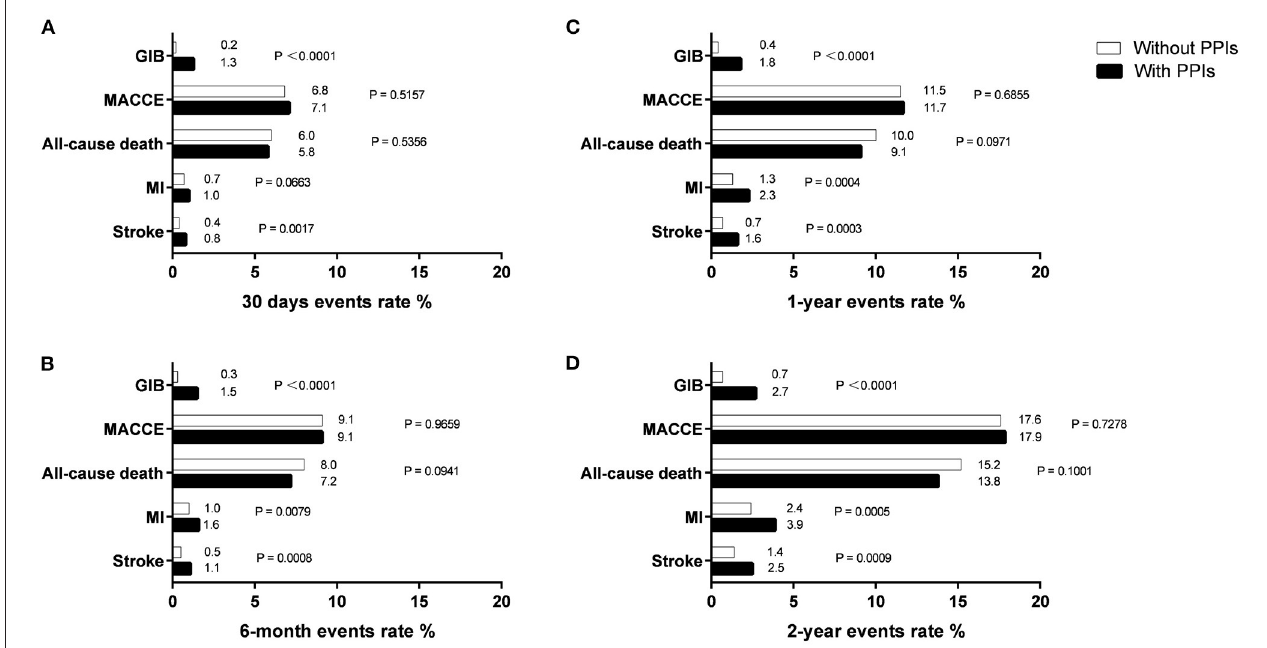
FIGURE 2 | Endpoints events rate at 30 days (A) , 6 months (B) , 1 year (C) , and 2 years (D) in patients with and without